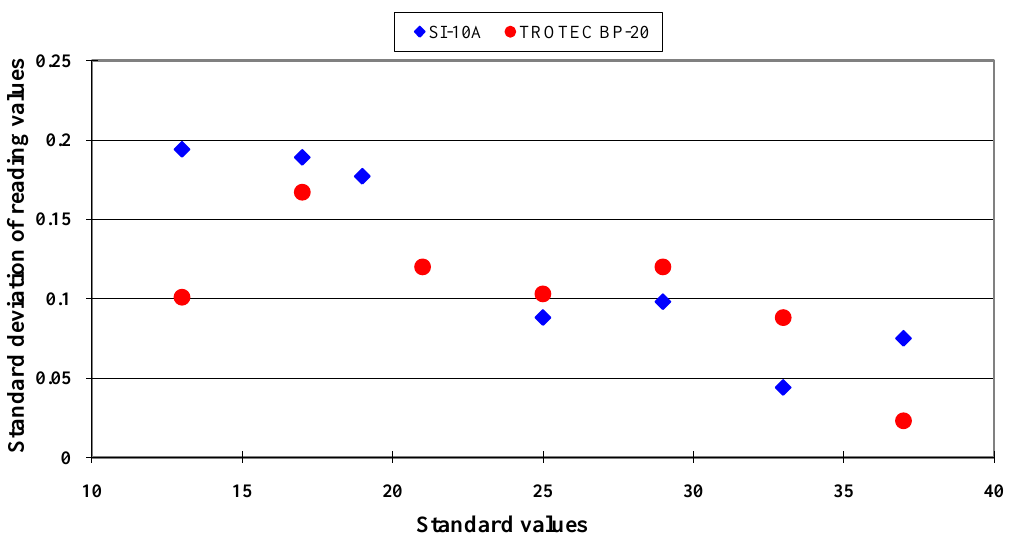
Figure 3. The standard deviations of the measured values at each standard environment for the Sentron SI-10A and Trotec BP-20 infrared thermocouple.